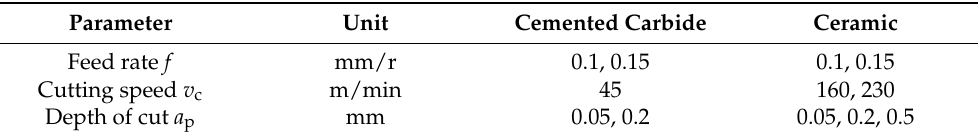
Table 2. Evaluated parameter values of the turning experiments.